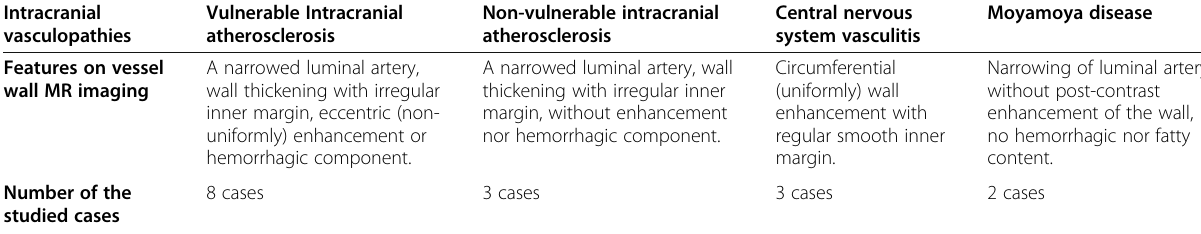
Table 6 Summary for vessel wall MR imaging criteria for different intracranial vasculopathies in the cases studied Intracranial vasculopathies